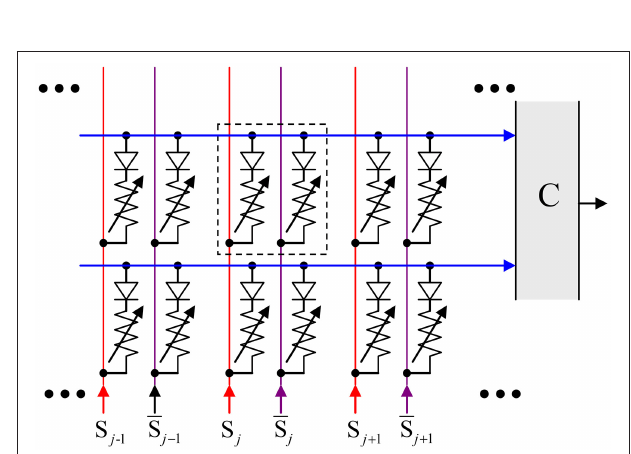
FIGURE 12 | The input pixel noise suppression by a CrossNet with N 101 10,201; M 21 21 – 1 440 in the process of movie retrieval, as = = × = simulated for 10 independent random noise patterns. The recording of the movie with Q 250 frames was performed using the discrete gradient = descent